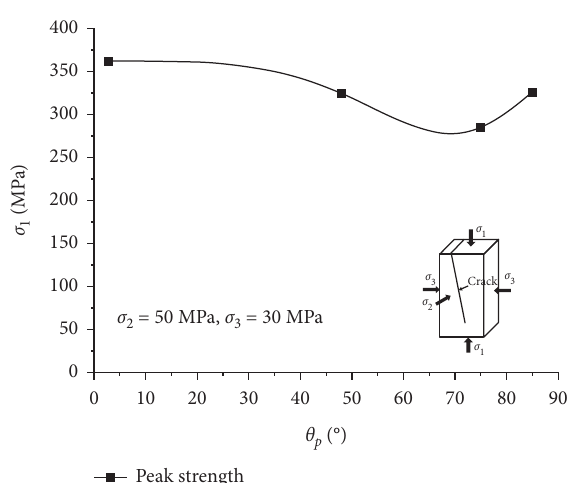
Figure 3: Experimental results of the preferential angle ( θ p ) effect on the peak stress of marble containing single crack.